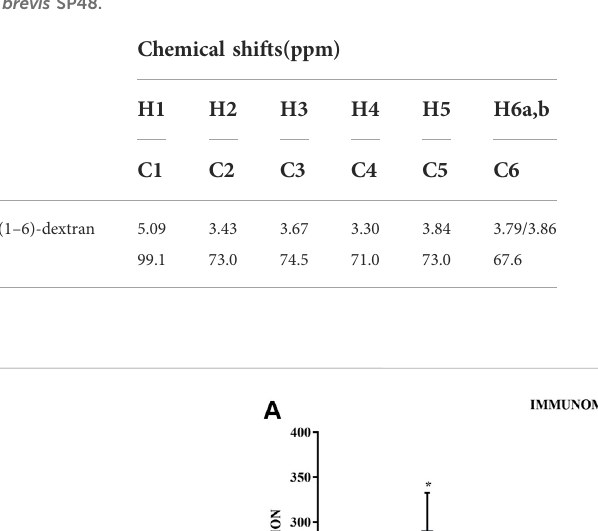
TABLE4 1 Hand 13 CNMRchemicalshiftsofthedextranoftheEPSfrom L. brevis SP48.